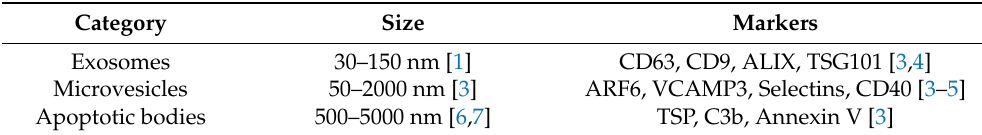
Table 1. Main EV